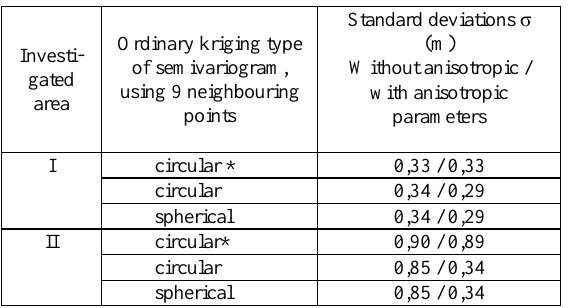
Table 5. Standard deviations of DEM in different territory of area 44